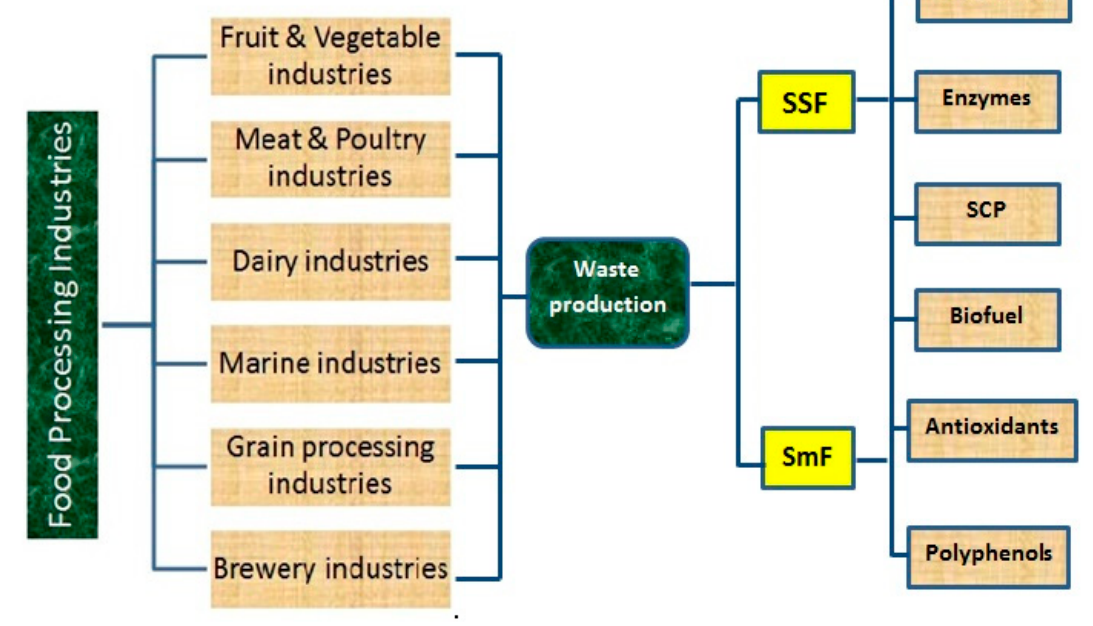
Figure 7. Production of bioactive compounds from food industries waste using fermentation.